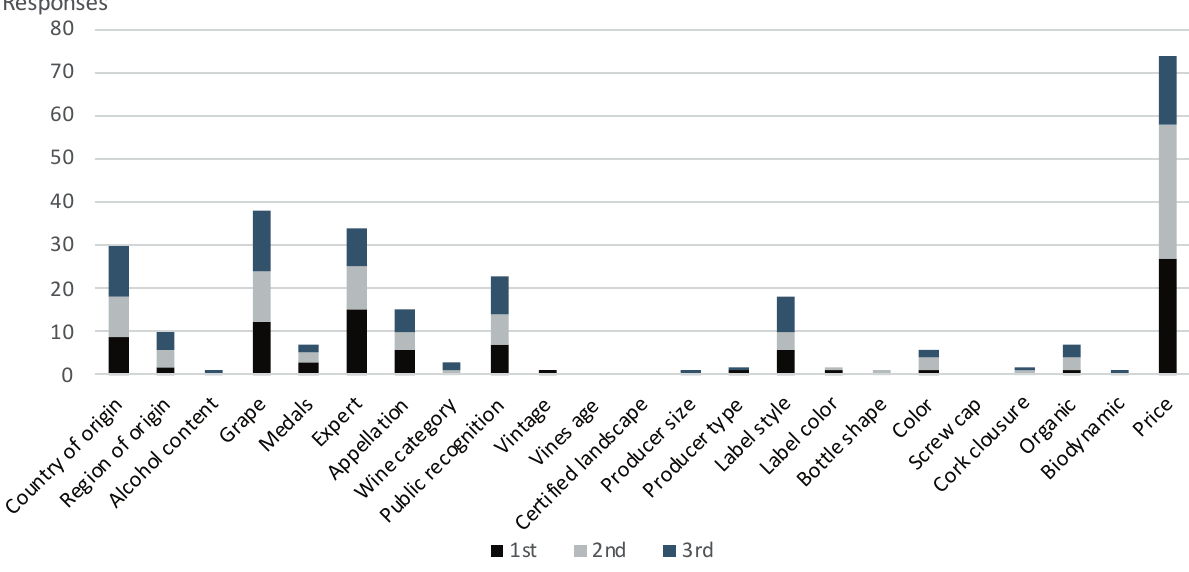
Figure 1. Three most attractive wine attributes in the market in which the distributor operates.